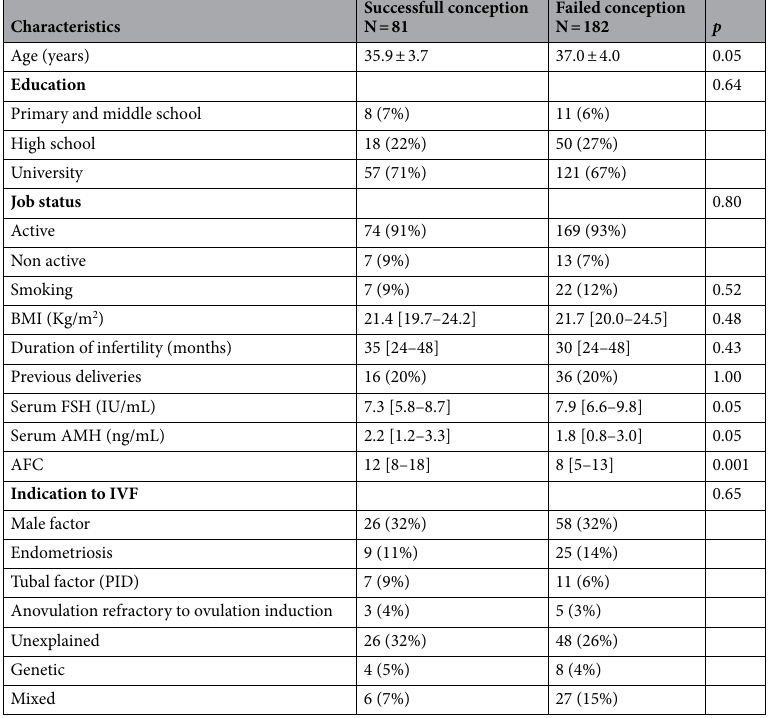
Table 1. Baseline characteristics of women who did and did not achieve clinical pregnancy. Data is reported as Mean ± SD, Median [IQR] or Number (%) as appropriate. BMI body mass index, FSH follicle stimulating hormone, AMH anti-mullerian hormone, IVF in vitro fertilization, PID pelvic inflammatory disease.